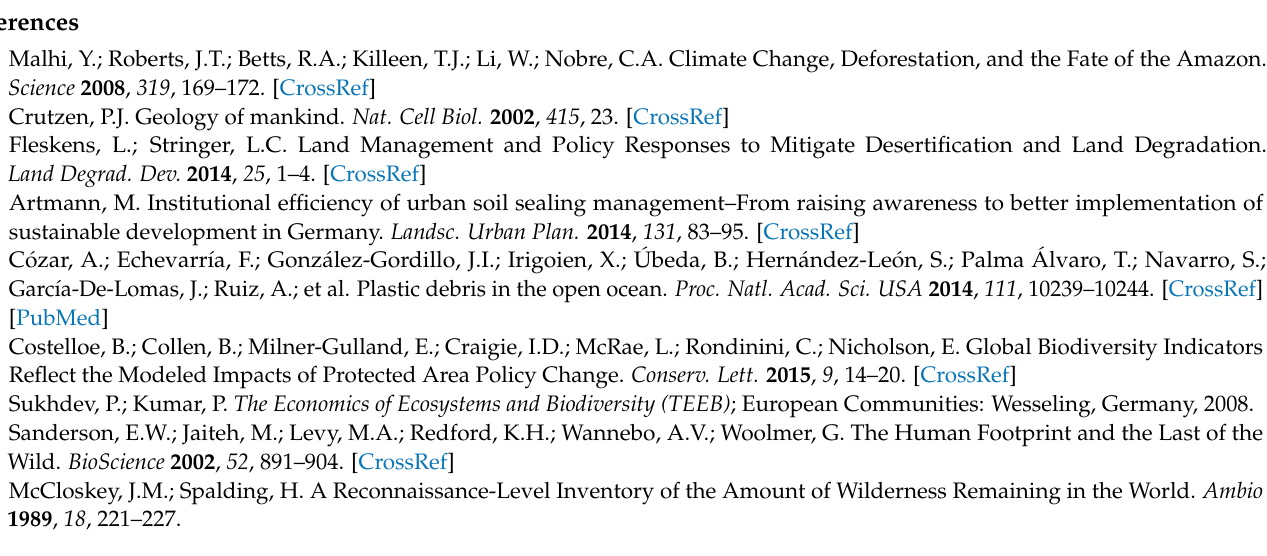
Table S4: Slope and significance of average NDVI in different regions during